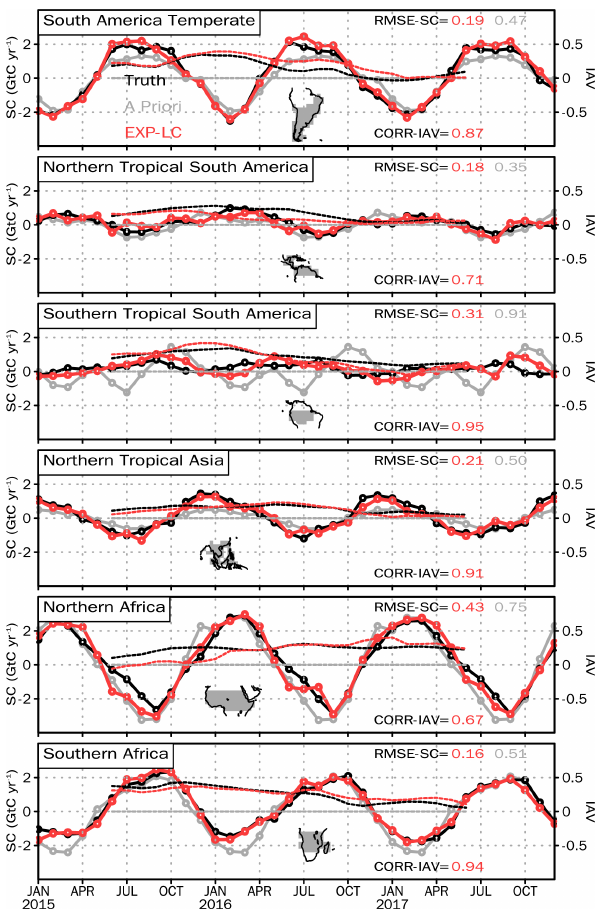
Figure 7. Same as in Fig. 6 but for the tropical regions.